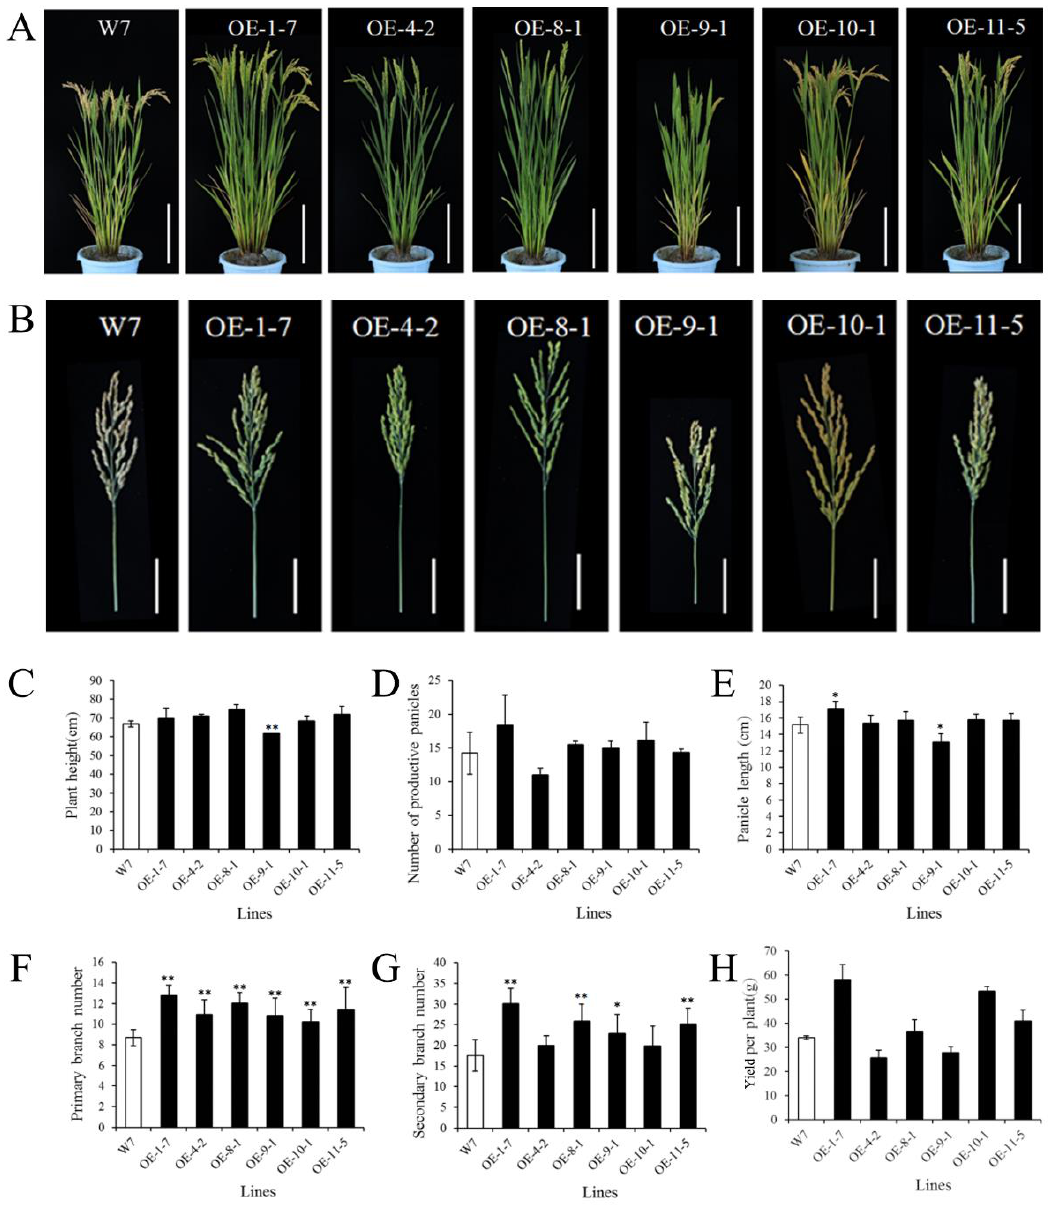
Figure 6. Phenotypes of CmPT2 -OE T2 lines at the reproductive stage. ( A ): Plant architecture of wild type W7 and CmPT2 -OE T2 lines at the reproductive stage. Bar = 20 cm. ( B ): Mature panicles of W7 and CmPT2 -OE T2 lines. Bar = 5 cm. ( C – H ): Comparisons between W7 and CmPT2 -OE T2 lines at the reproductive stage for average plant height ( C ), number of productive panicles ( D ), panicle length ( E ), number of primary branches ( F ), number of secondary branches ( G ), and yield per plant ( H ). Values are given as the mean ± SD. “**” and “*” indicates a significant difference at the 0.01 and 0.05 level, respectively.